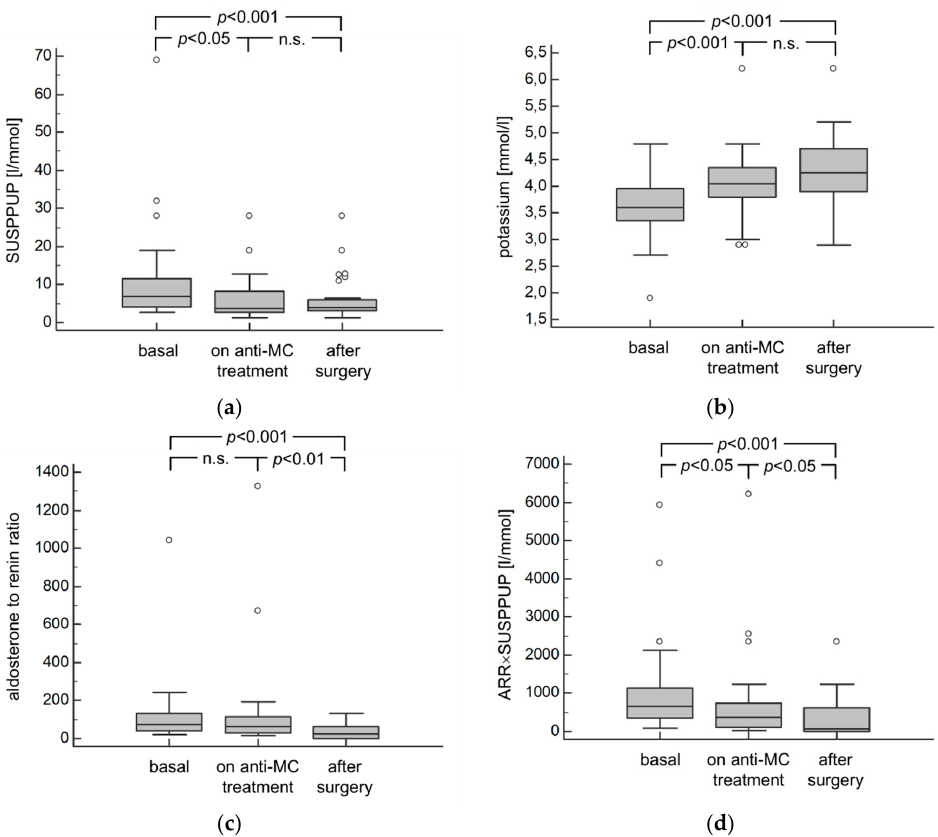
Figure 3. Panels show the change in the SUSPPUP ratio ( a ), serum potassium ( b ), the ARR ( c ) and ARR×SUSPPUP ( d ) from baseline, over anti-mineralocorticoid (MC) treatment to a visit between 1 and 3 months after adrenalectomy in patients with PA. Plasma renin concentrations were 5.7 ± 5.7 pg/mL on anti-MC treatment (please, see also the Patients and Methods section). Table 6. Influence of antihypertensive medication on parameters in di ff erent patient groups. Medication